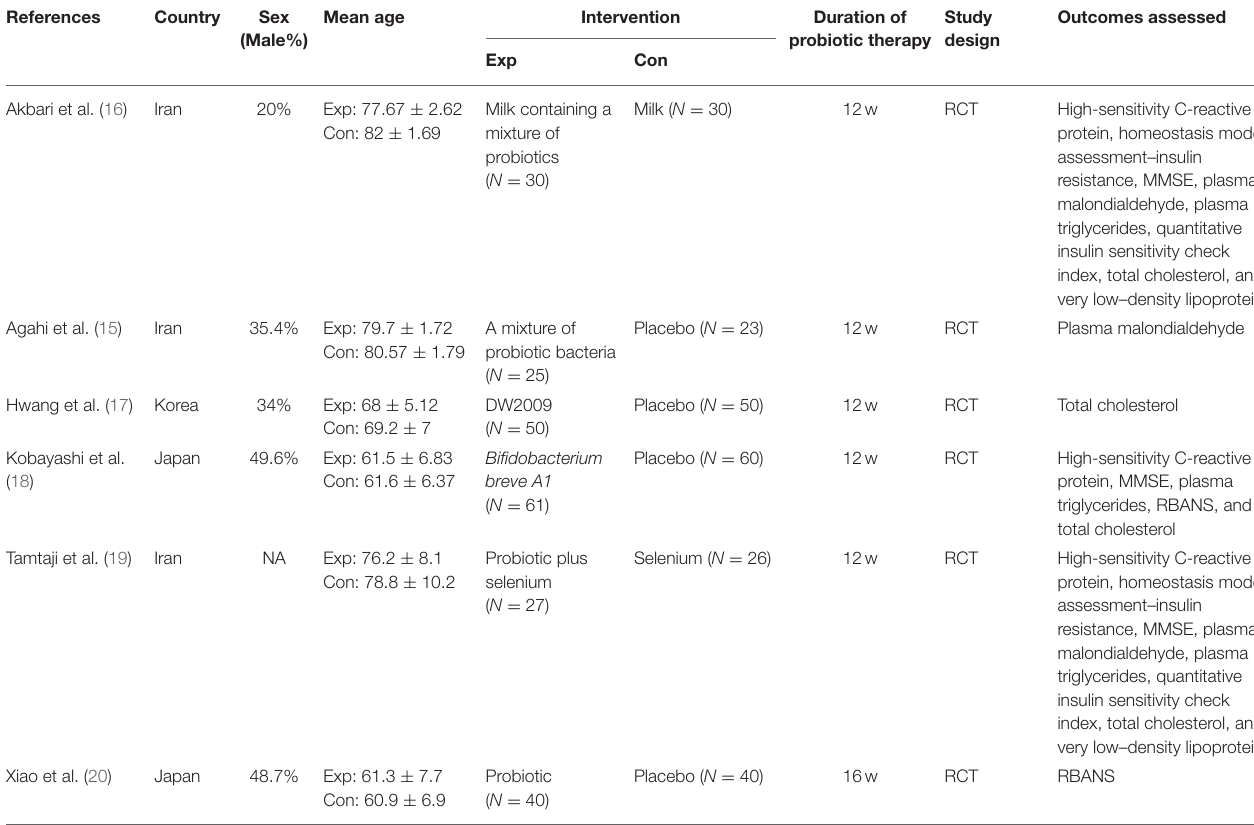
TABLE 1 | Characteristics of the studies included in this meta-analysis.